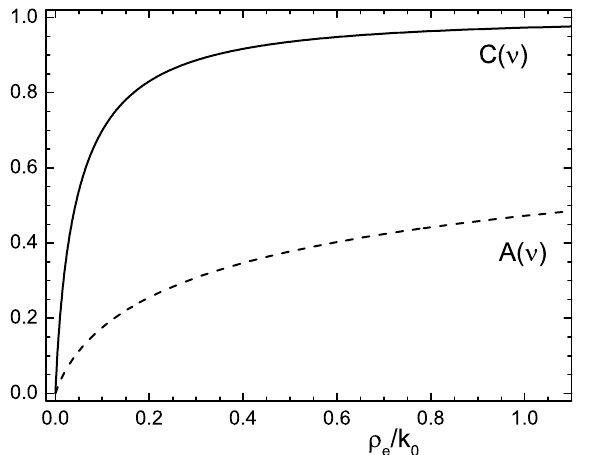
Figure 1. Plot of the functions A ( ν ) and C ( ν ) of Equation (13), where ν = ( 3 πρ e / k 0 ) 1/3 , as a function of the normalized electron density ρ e / k 0